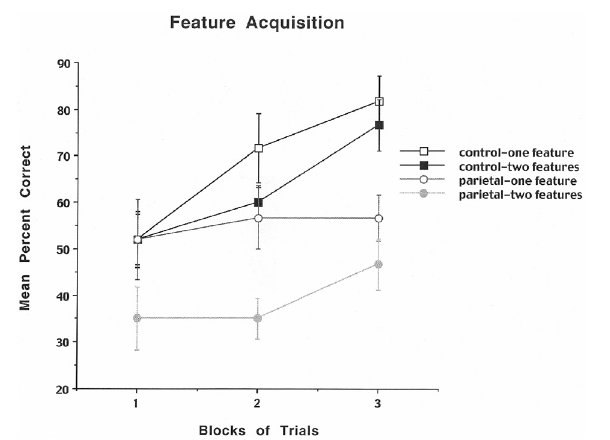
FIGURE 2 | Mean number of search errors for one or two features for control and parietal cortex lesioned rats as a function of blocks of trials. Each block consisted of 20 trials.